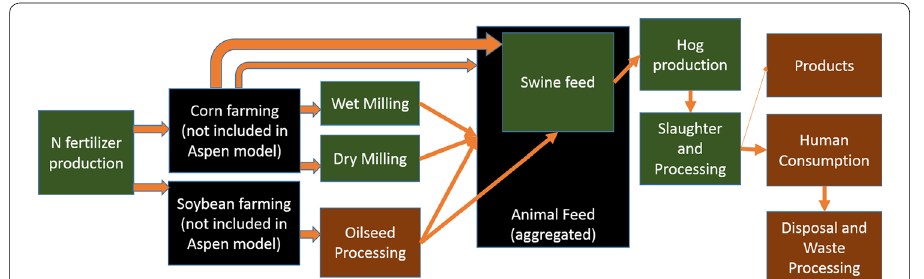
Fig. 4 Models along the corn supply chain completed for this work are shown in green. Black sectors are excluded from the work since they are not suitable for Aspen modeling at this stage. Brown denotes sectors that have not yet been